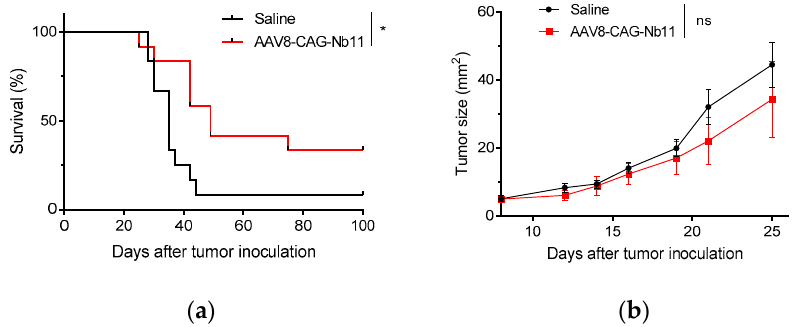
Figure 7. Prevention of tumor development in mice treated with AAV-CAG-Nb11. C57BL/6 mice that had received 10 11 vg of AAV-CAG-Nb11, and control mice (that received saline solution), were challenged with 5 × 10 5 MC38 cells eight weeks after treatment. ( a ) Survival after tumor challenge. ( b ) Mean tumor size evolution (mm 2 ) ± SEM. * p < 0.05, ns: not significant.